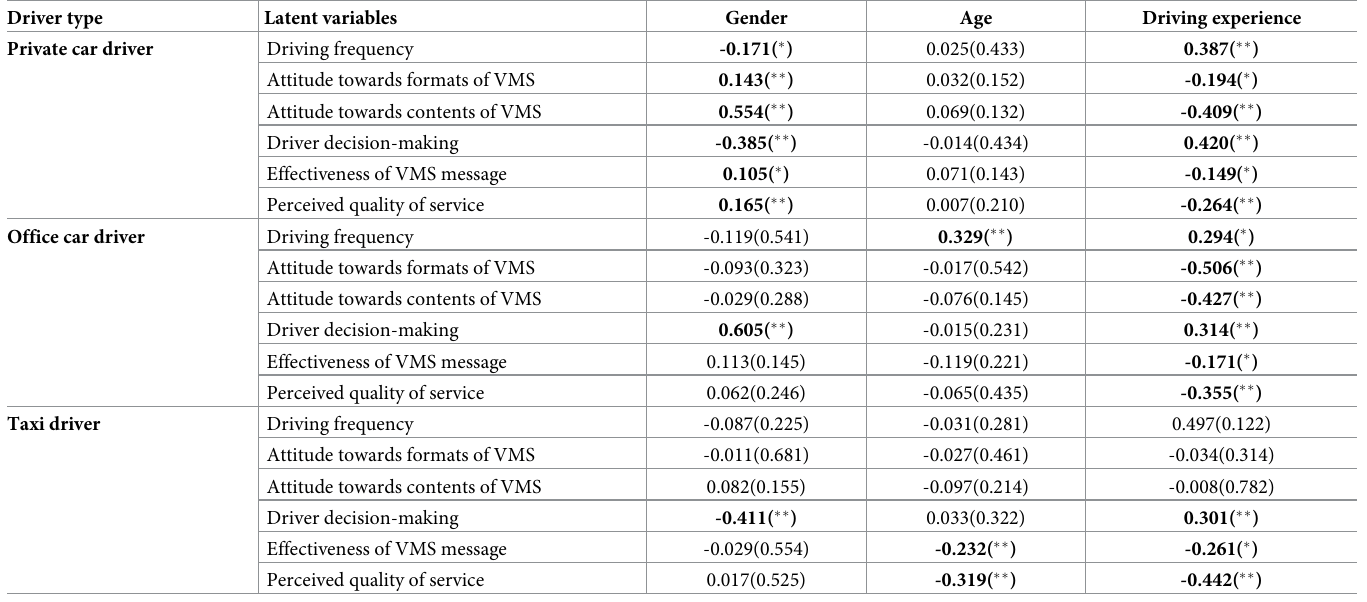
Table 5. The estimation results between socio-demographic characteristics and latent variables.